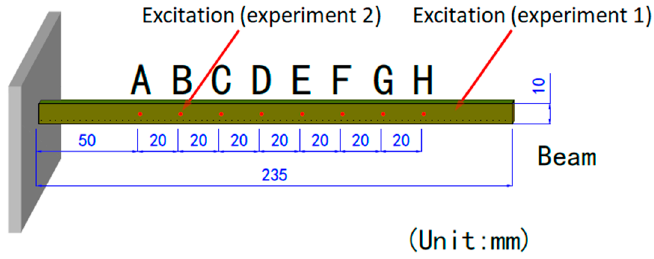
Figure 18. Dimension diagram of cantilever beam.